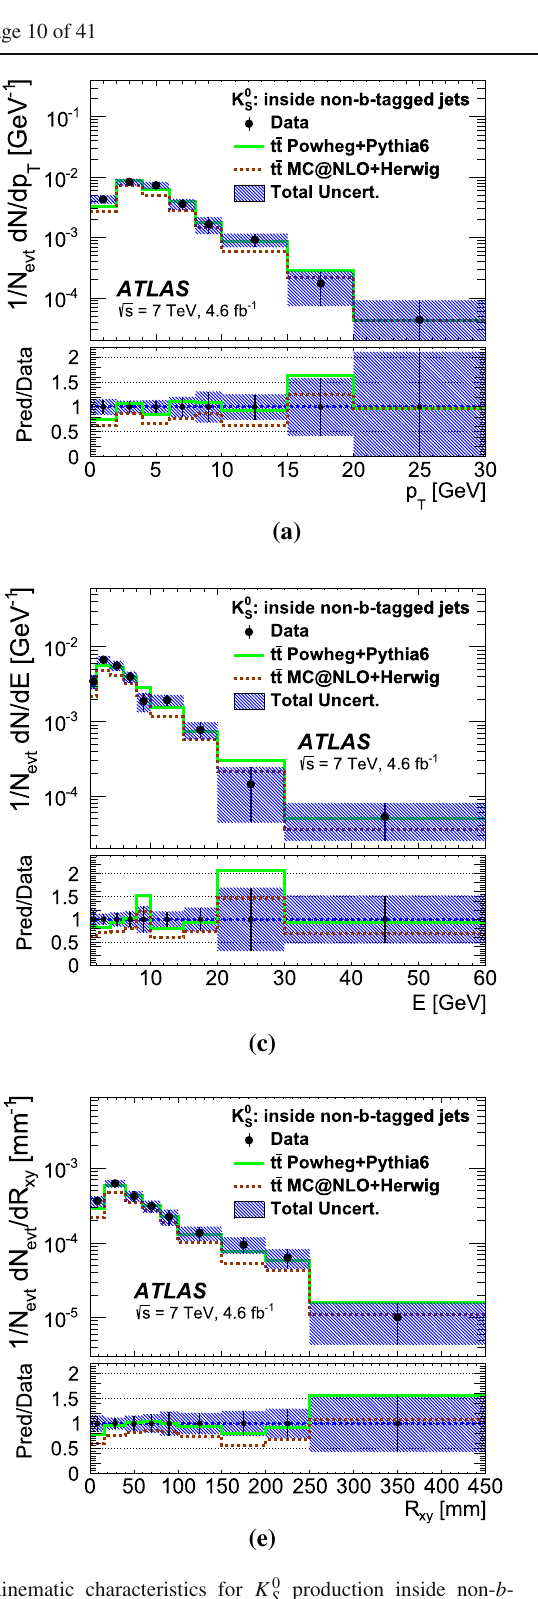
Fig. 4 Kinematic characteristics for K 0 production inside non- b - tainties are represented by the shaded area. Statistical uncertainties for S tagged jets, for data and detector-level MC events simulated with the MC samples are negligible in comparison with Powheg + Pythia6 and MC@NLO + Herwig generators. Totaluncer-